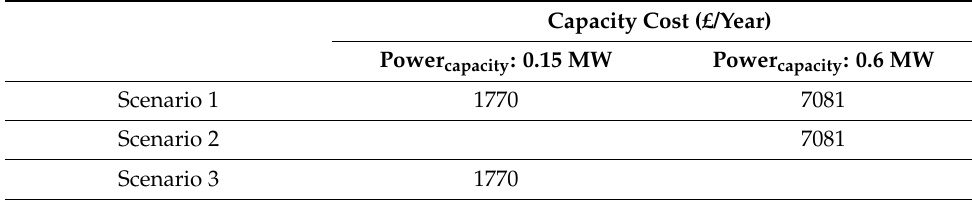
Table 3. Annual capacity charge for each scenario